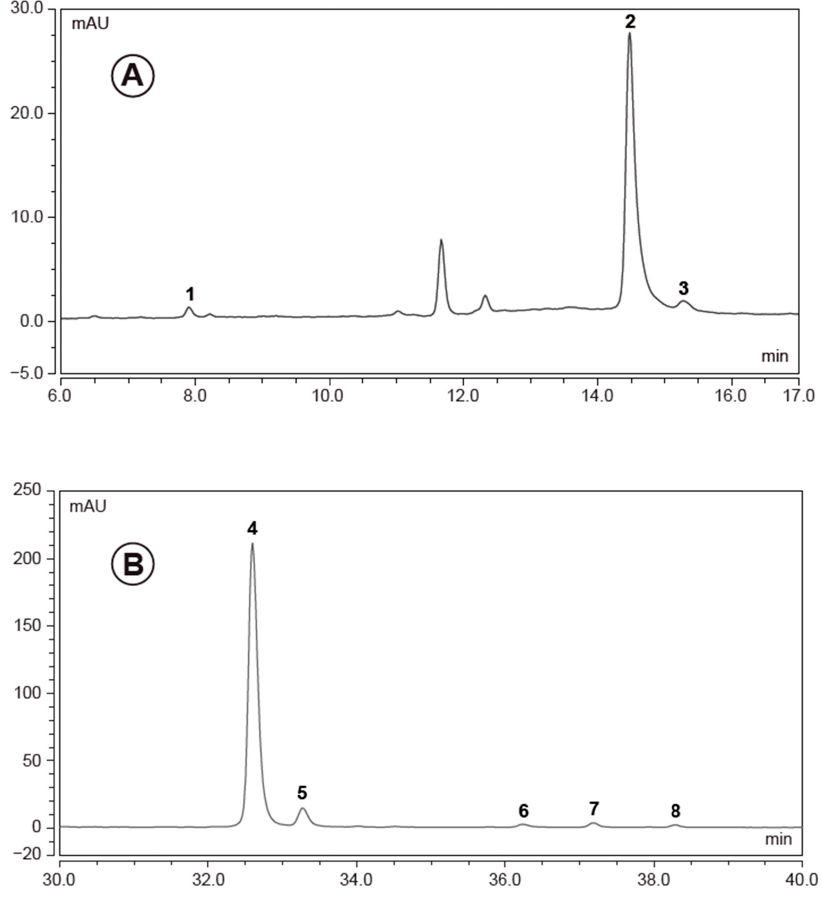
Table 1. Quantitative analysis of compounds in black elderberry extracts EC 3.2 and EC 14.